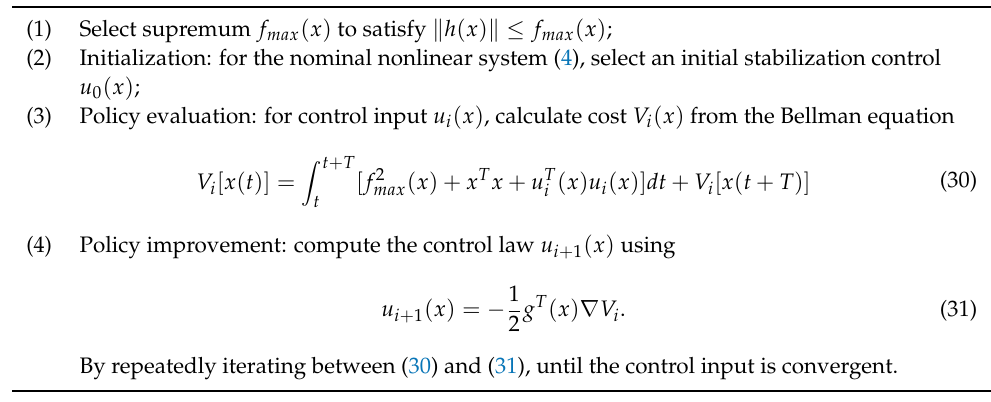
Algorithm 1 PI algorithm of robust control for matched uncertain nonlinear